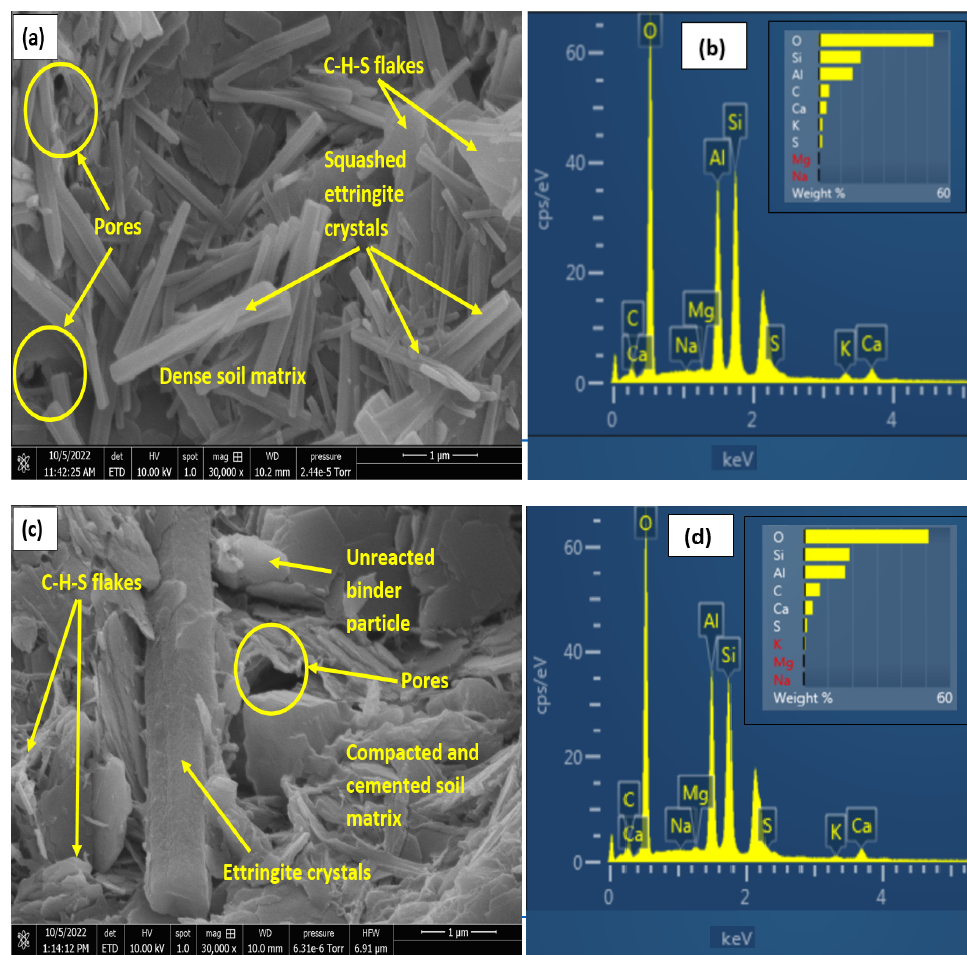
Figure 13. SEM and EDX results of 28-days cured LGGBS-treated gypseous samples. ( a ) SEM of 15%Gypseous soil. ( b ) EDX of 15%Gypseous soil. ( c ) SEM of 35%Gypseous soil. ( d ) EDX of 35%Gypseous soil.